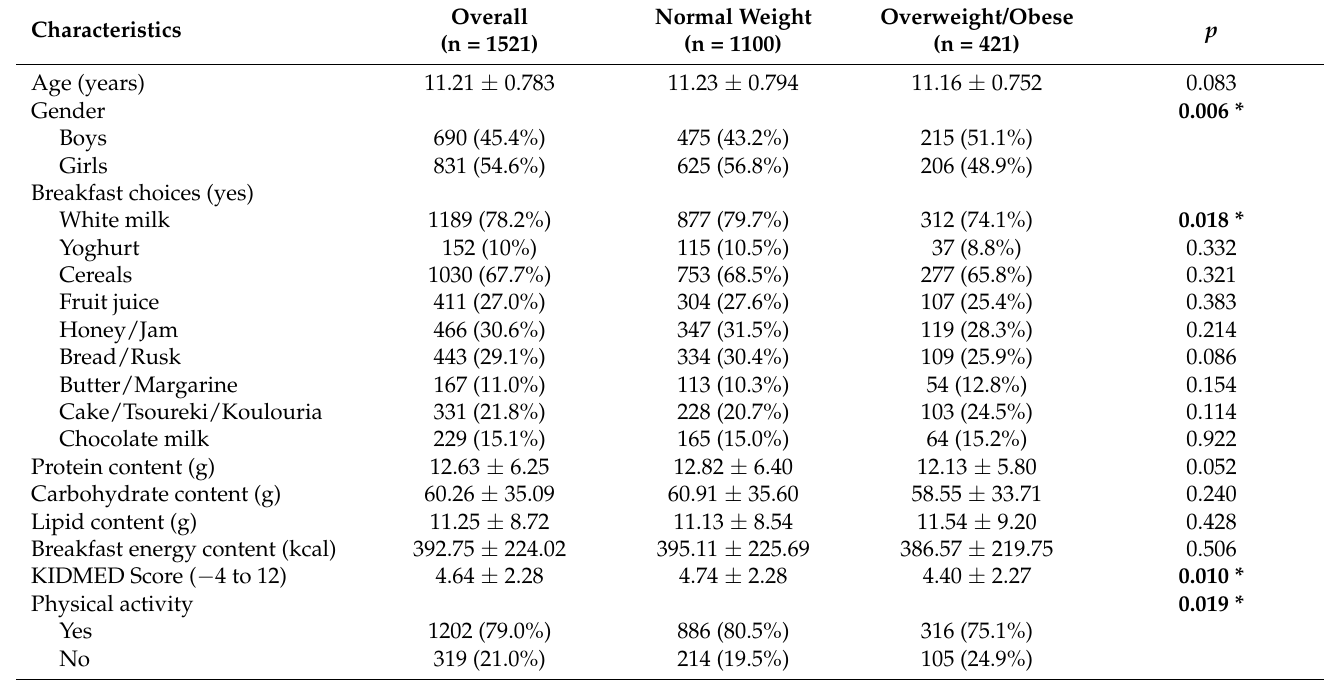
Table 1. Characteristics of the children by body weight